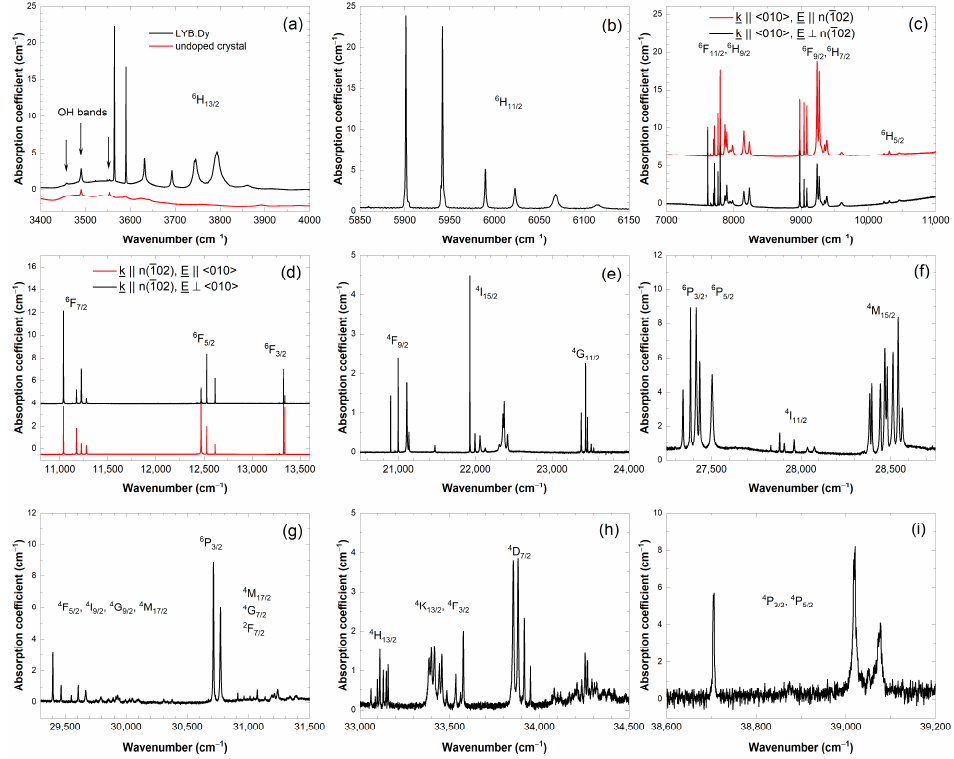
Figure 3. Absorption spectra of Dy 3+ ions in LYB:Dy(5 mol%) single crystal measured in the infrared ( a – d ), visible ( e ) and UV ( f – i ) spectral range at T = 8 K. Transitions from the lowest level of the 6 H 15/2 ground state to various multiplets are indicated.